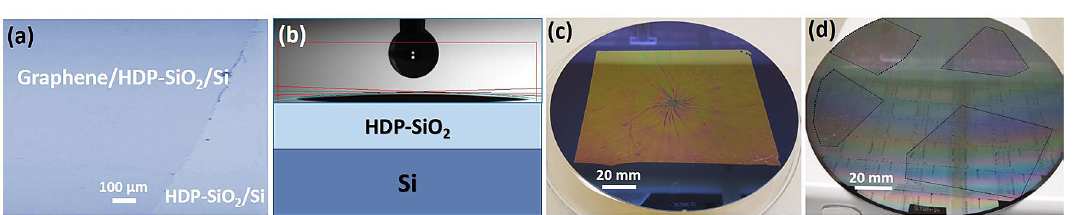
Figure 8. Optical microscopy picture of ( a ) graphene flake transferred on HDP-SiO 2 surface with wettability angle of 2.4°, ( b ) schematic drawing of water drop on the surface with WCA = 2.4°, ( c ) large-scale PMMA/ graphene flake transferred on HDP-SiO 2 /Si surface ( d ) transferred graphene flakes (without PMMA resist) on structured 200 mm